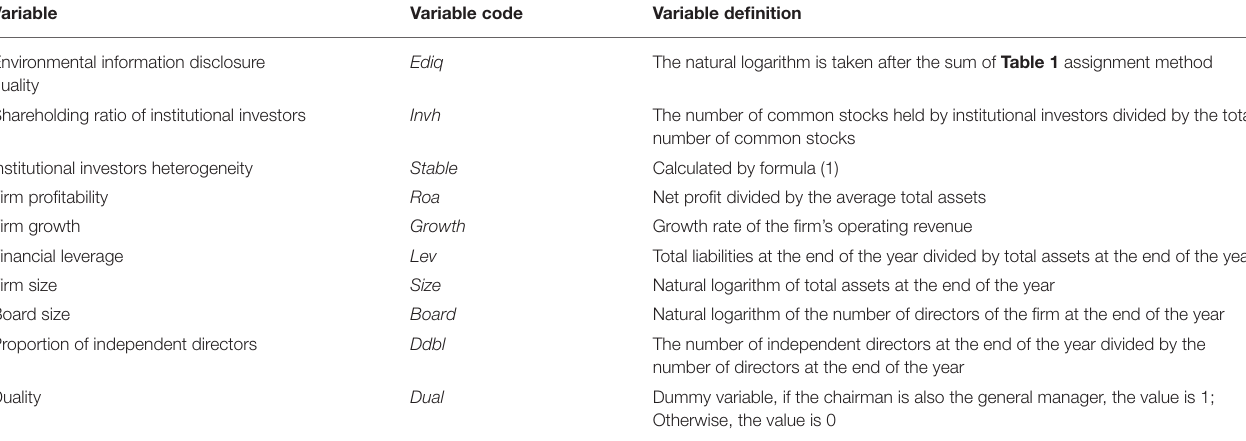
TABLE 2 | Definition of relevant